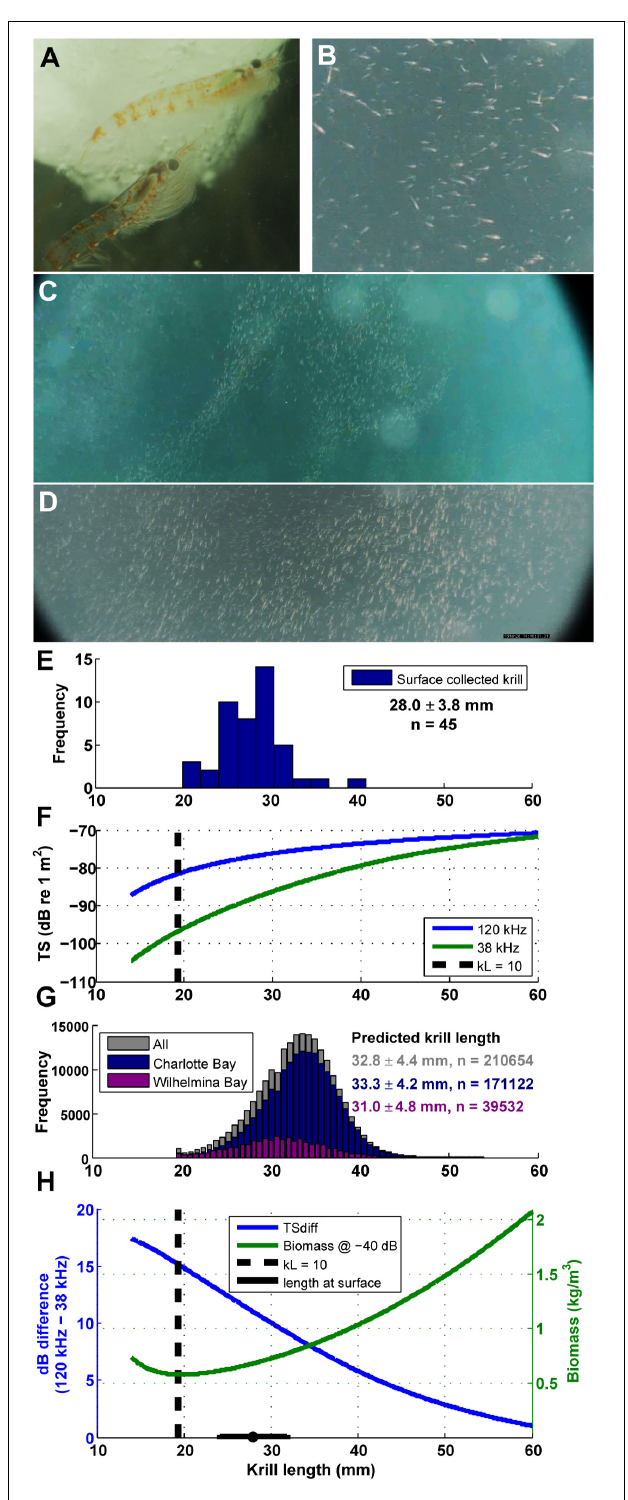
FIGURE 4 | Euphausia superba behavior and size. (A) Live krill collected in Wilhelmina Bay, photo credit: Natural History New Zealand. (B–D) Surface krill filmed after the camera tag deployed on mn200315–58 detached from the animal (see also Supplementary Video 2 ). (E) Length frequency histogram of